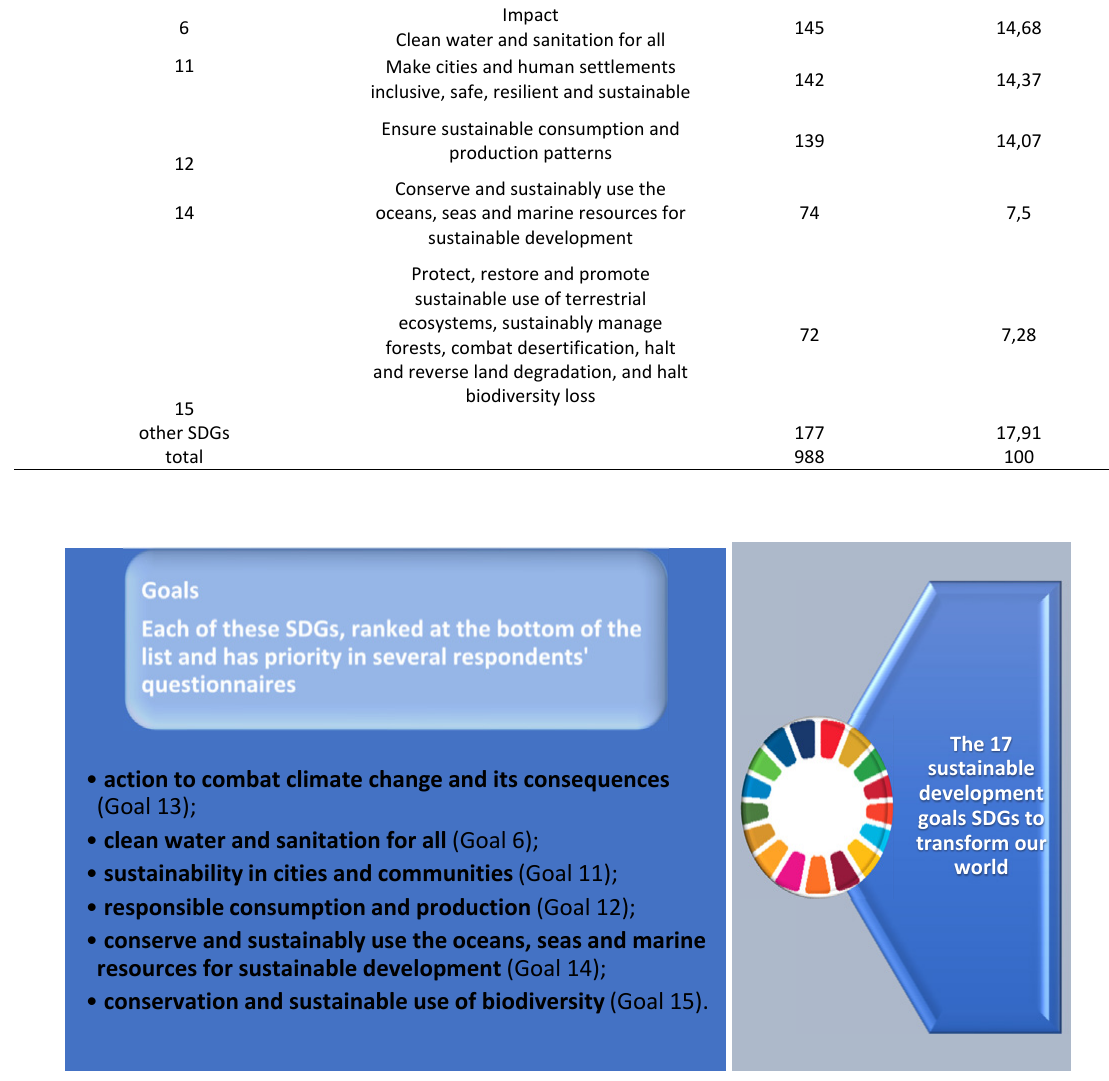
Fig. 3: The respondents’ questionnaire results